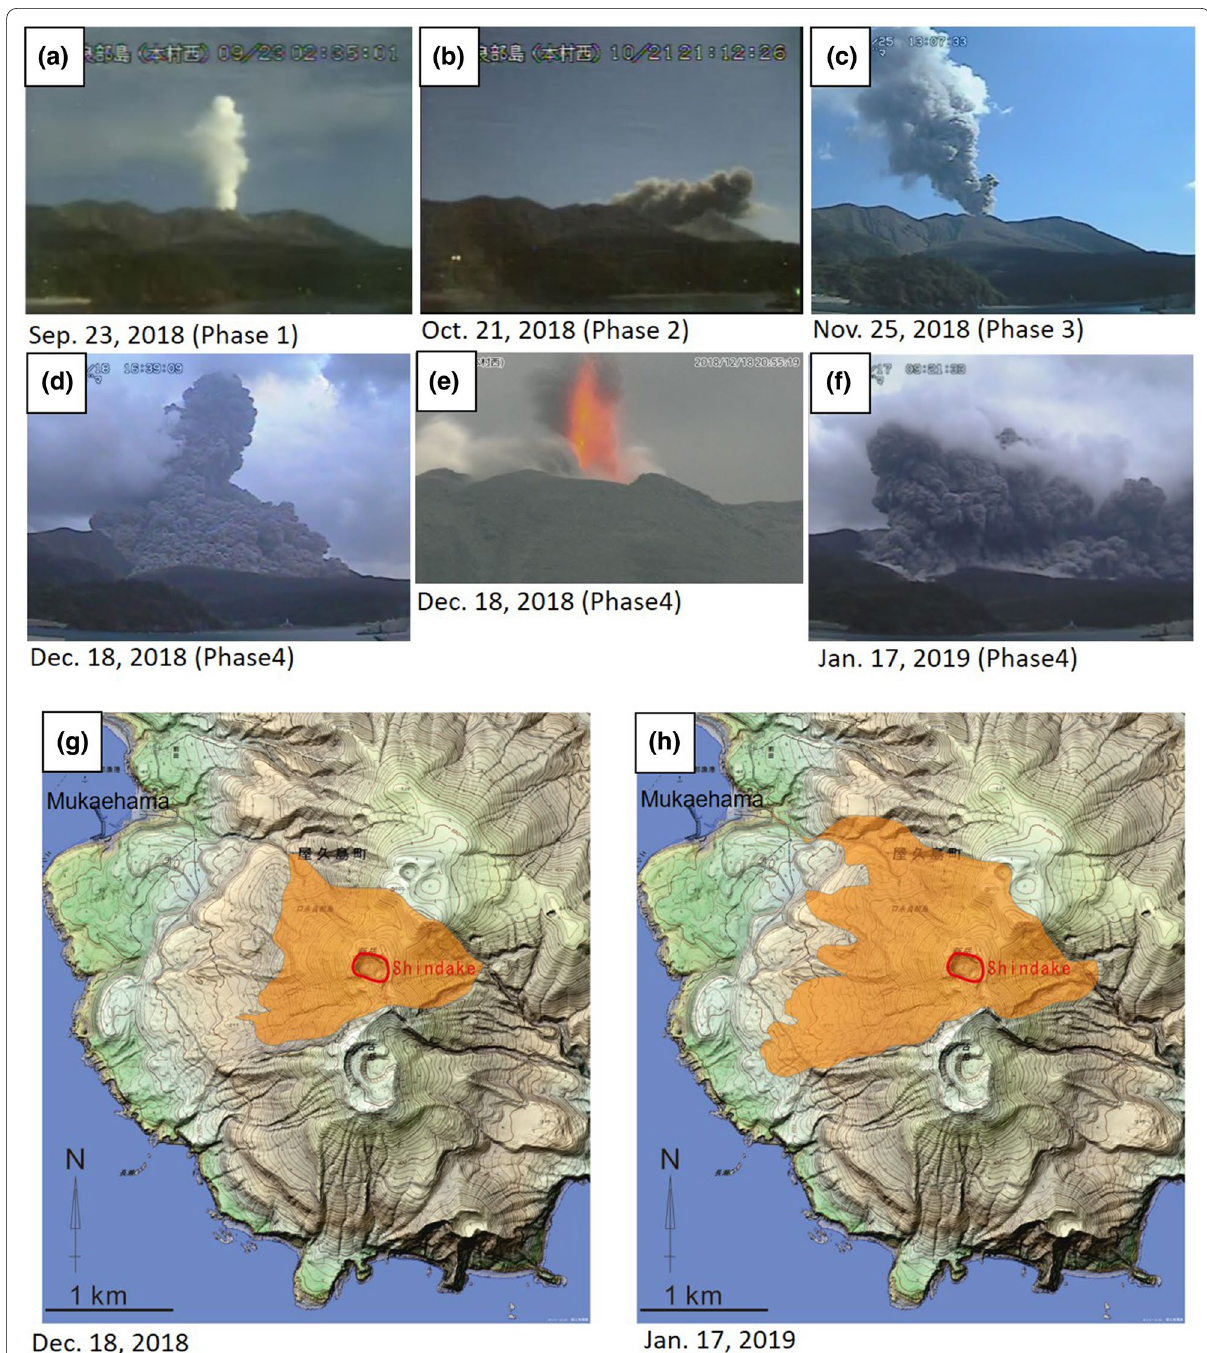
Fig. 3 Snapshots of the volcanic plumes and PDCs from the monitoring camera located 3 km NW of Shindake operated by Japan Meteorological Agency A – F and distribution of PDCs ( G , H ). A White volcanic plume during Phase 1. B Colored volcanic plumes during Phase 2. C Colored volcanic plumes during Phase 3. D The explosive activity at 18 December 2018 (Phase 4). The front of the PDC can be recognized at the foot of the eruption column. E Volcanic glow observed by high-sensitivity monitoring camera during the night of 18 December 2018, after a PDC occurred (20:55 ′ 19 ″ JST). F Second PDC occurred on 17 January 2019 (Phase 4). G , H Orange colored area indicates distribution of PDCs on 18 December 2018 G and